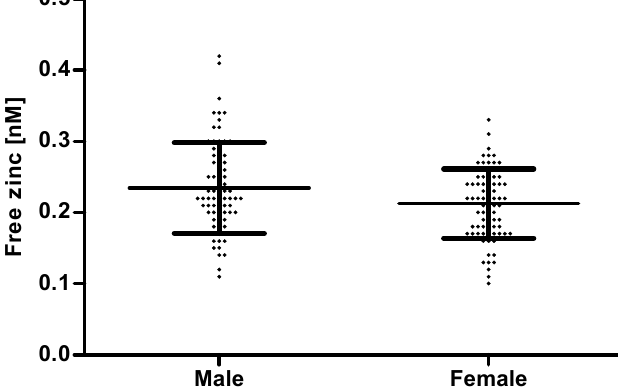
Figure 8. Comparison of the free zinc concentration in serum samples of males and females. The free zinc concentration was measured using the method established above. Data points represent means of n = 3 independent experiments and are depicted as scatter plots with means ± SD from 75 males and 79 females, respectively. Mean values for males and females were significantly different (unpaired t-test, p ≤ 0.05).